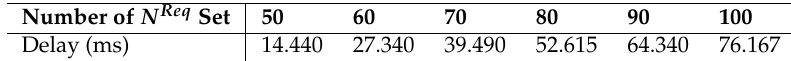
Table 4. Delay based on the number of N Req set.